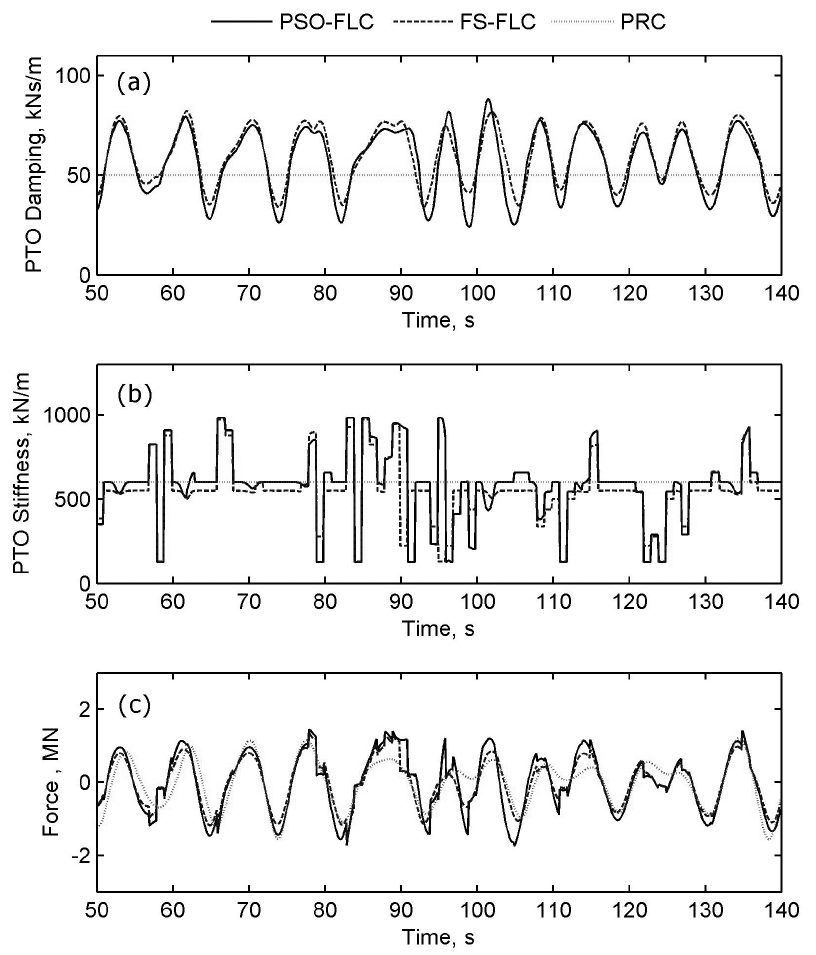
Figure 6. The dynamics of the WEC PTO ( a ) damping coefficient; ( b ) stiffness coefficient; ( c ) PTO control